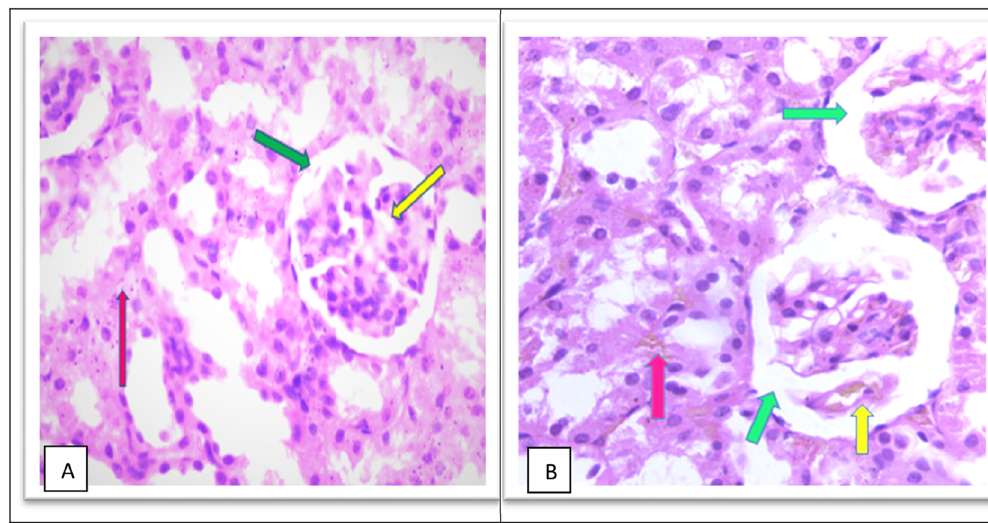
atrophy with widening of the urinary space (green arrow), (green arrow), severe congestion is also observed in the interstitial (pink arrow) (H&E (cid:1) 40).